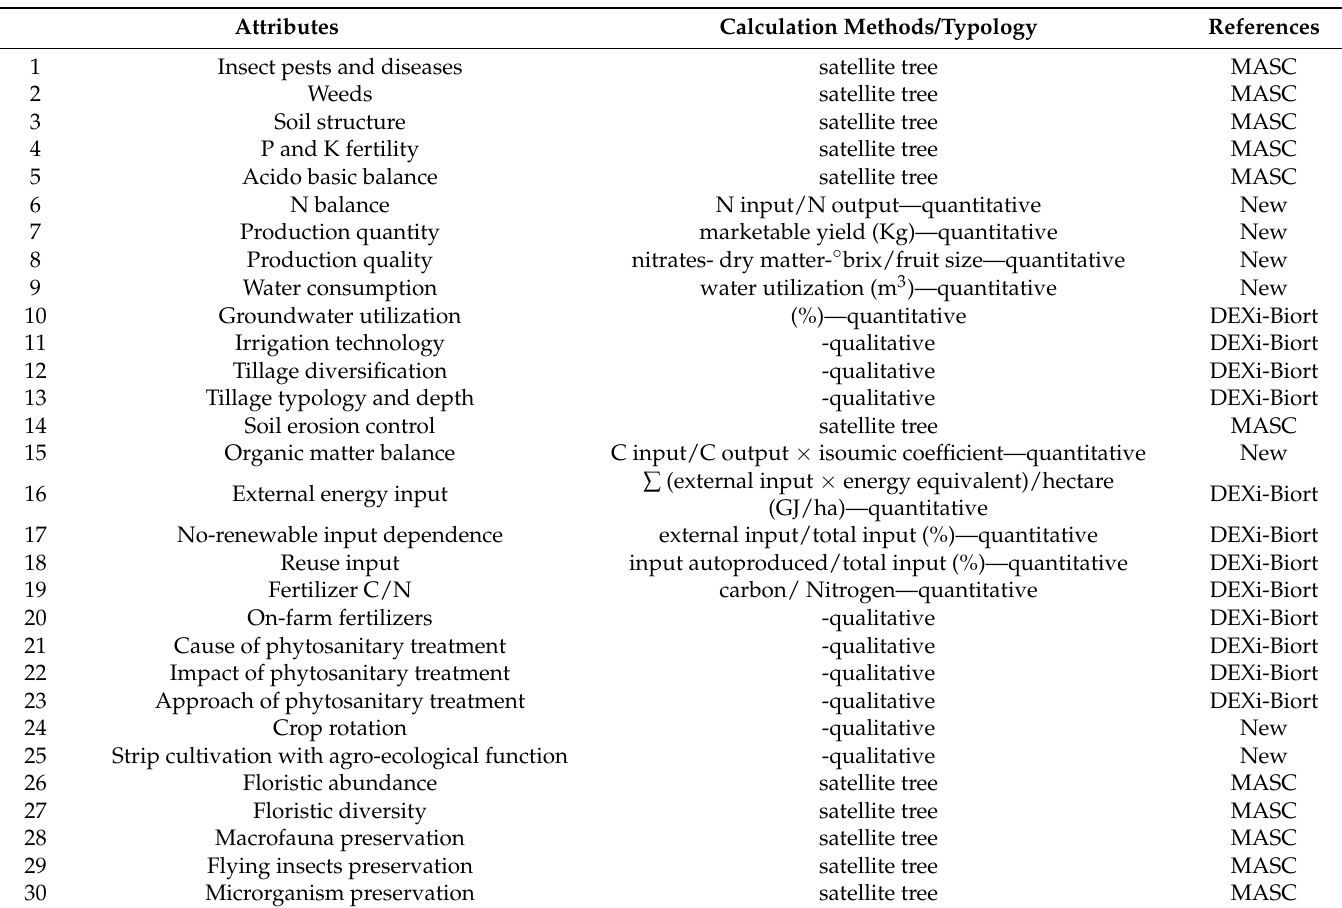
Table 1. Summary of the different knowledge sources used as input attributes in the DEXi-met model. Input attributes name, methodology used to calculate/estimate the input attributes/typology, and references (MASC = [15]; DEXi-Biort = [21]; new = new attributes) in the